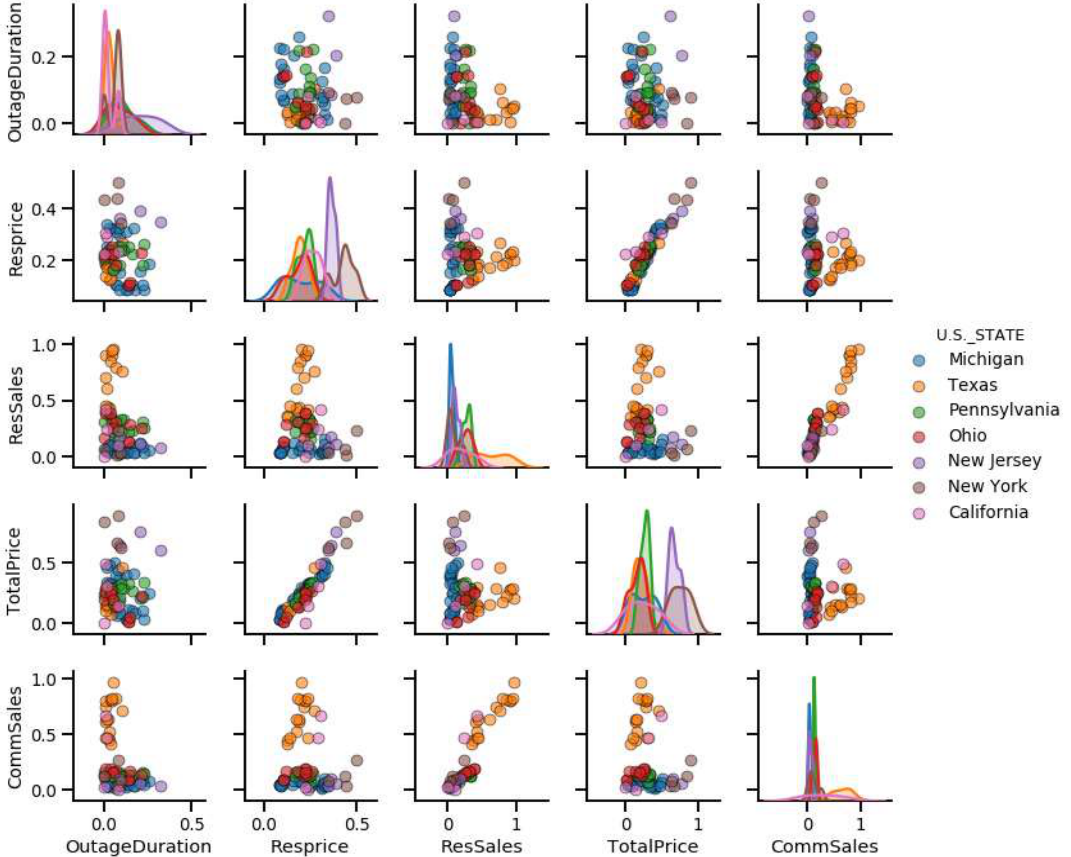
Figure 19. Feature correlations for top five important features for the thunderstorm disaster cate- gory.